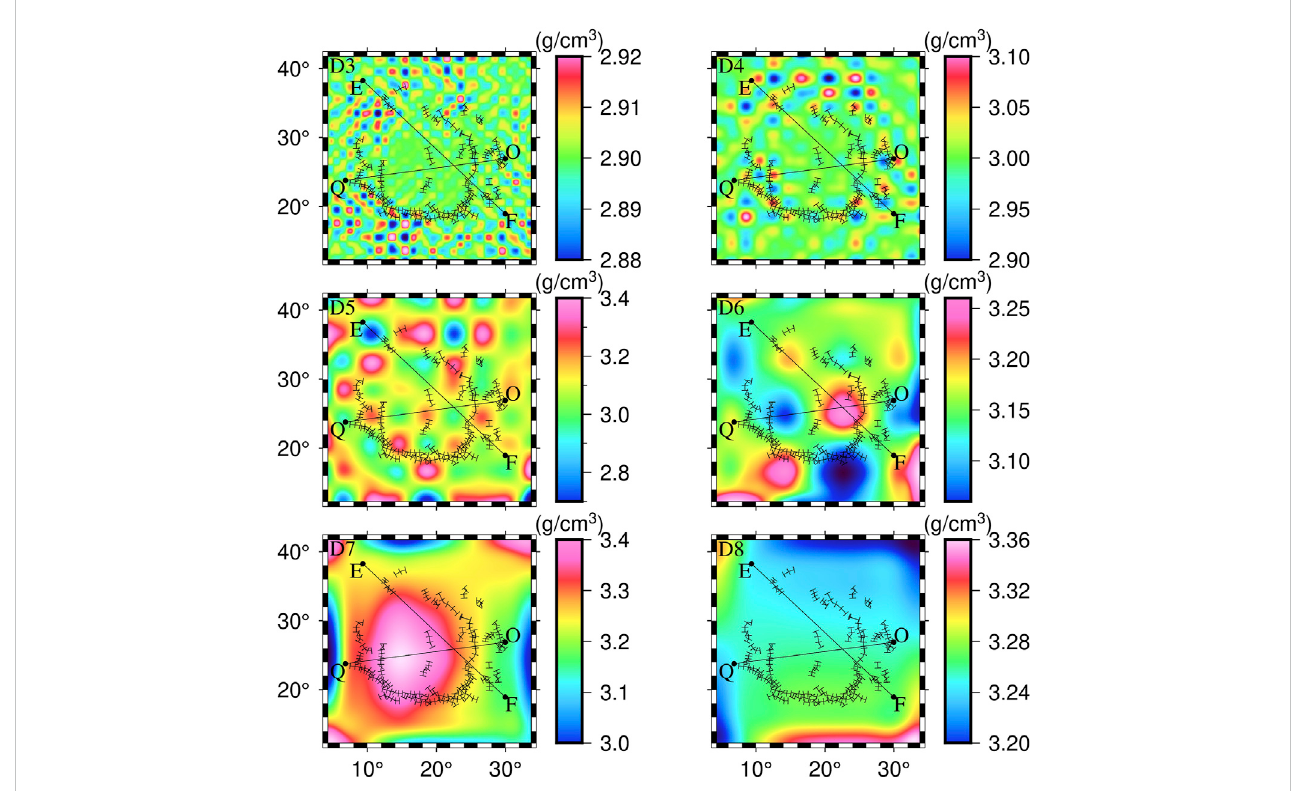
FIGURE 5 Results of the layered density inversion in the Mare Serenitatis. E-F and O-Q are the location of pro fi le density inversion.